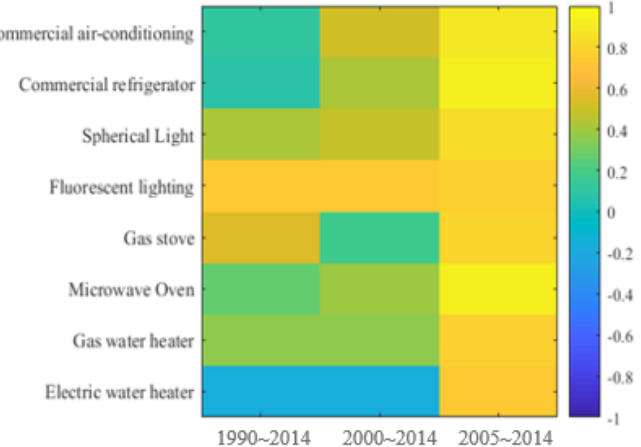
Figure 8. Correlation between equipment energy efficiency improvement and energy consumption of tertiary industry in different stages.